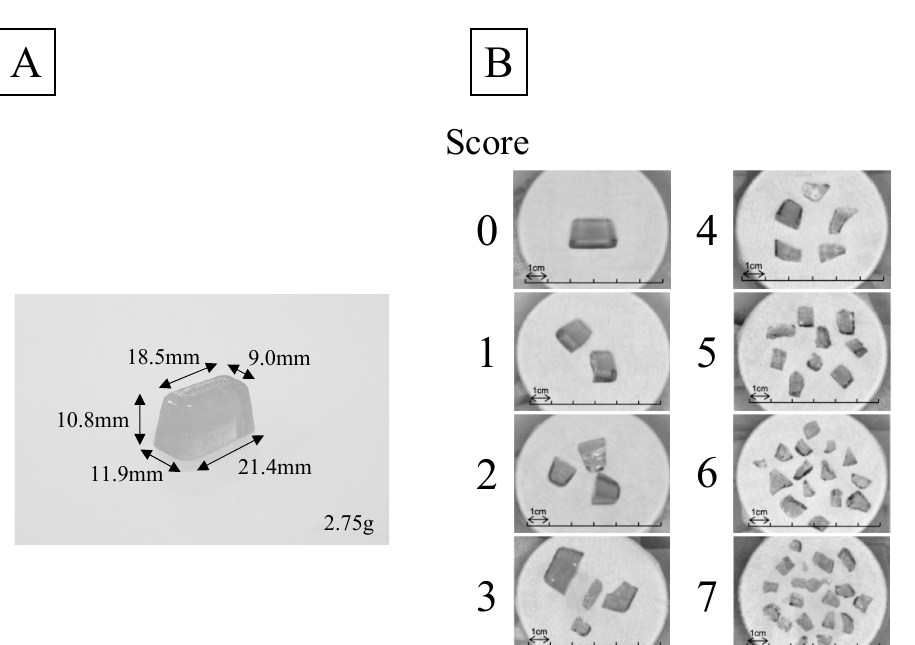
Figure 2. Evaluation of masticatory performance with half-size test gummy jelly. ( A ) A sample of the half-size test gummy jelly. ( B ) The visual scoring table of half-size test gummy jelly. The gummy jelly used in this new test is half the size of that used in the conventional test (Figure 1A), and the score table is different from that of the conventional test (Figure 1B).